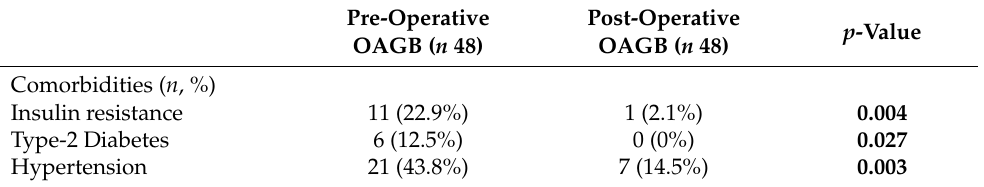
Table 6. Pre- vs. post-operative data for